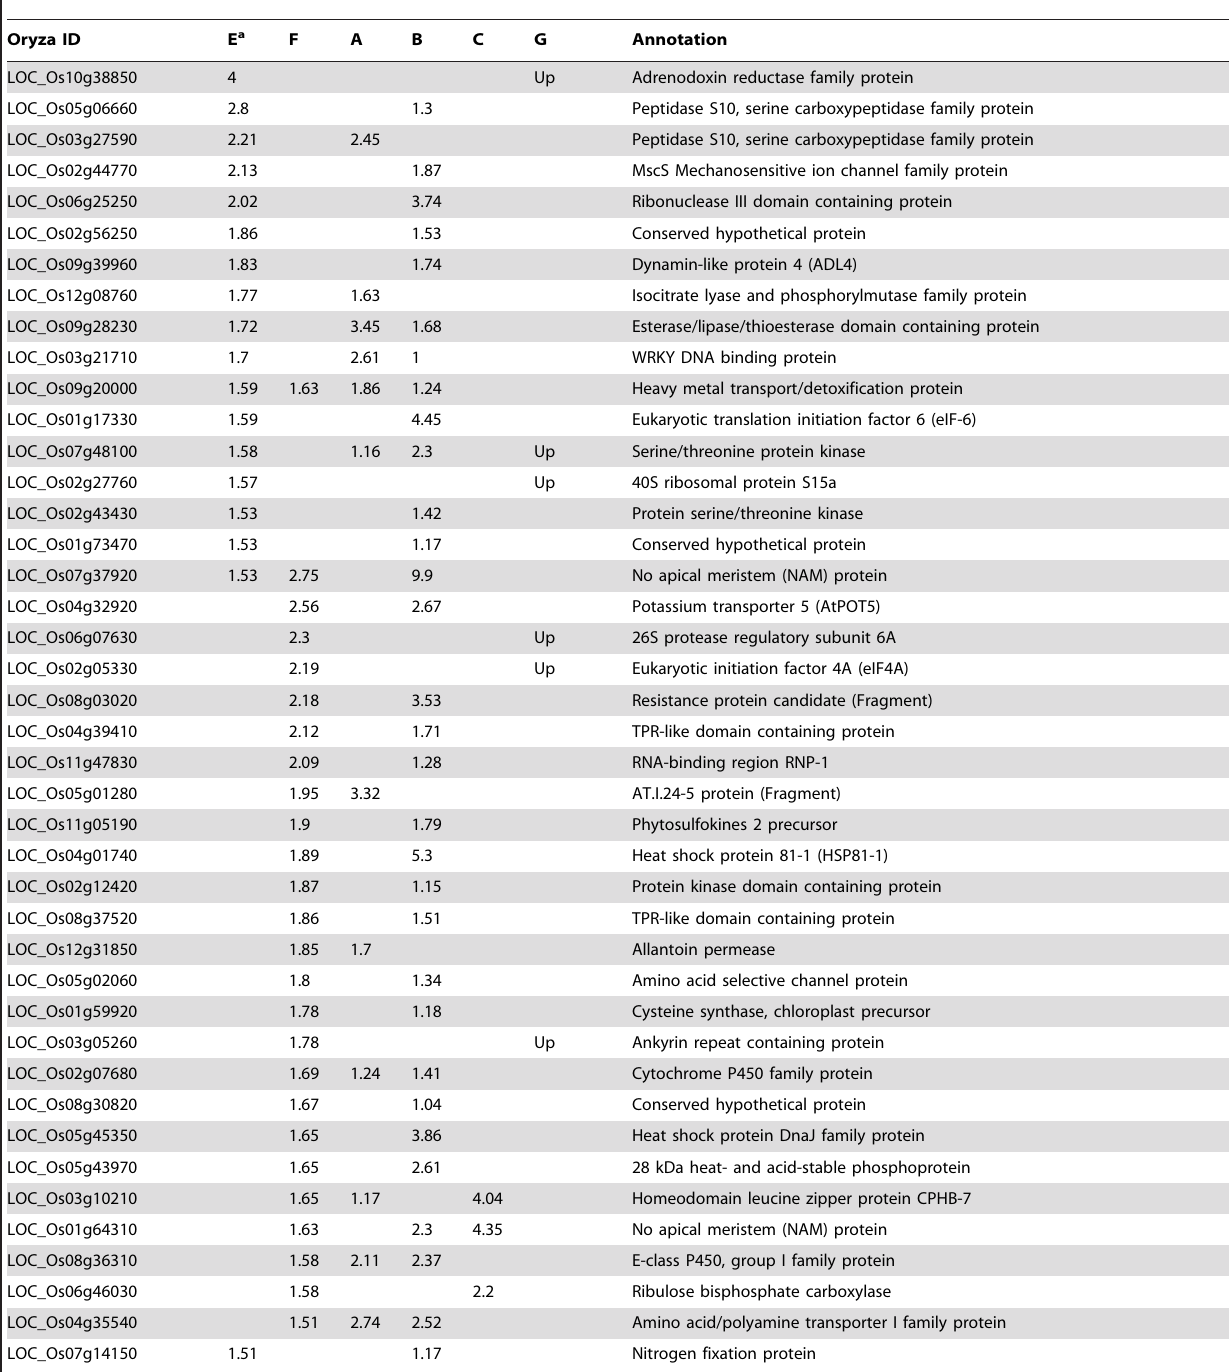
Table 3. The list of up regulated genes in the comparison of the rhizome related DEGs.